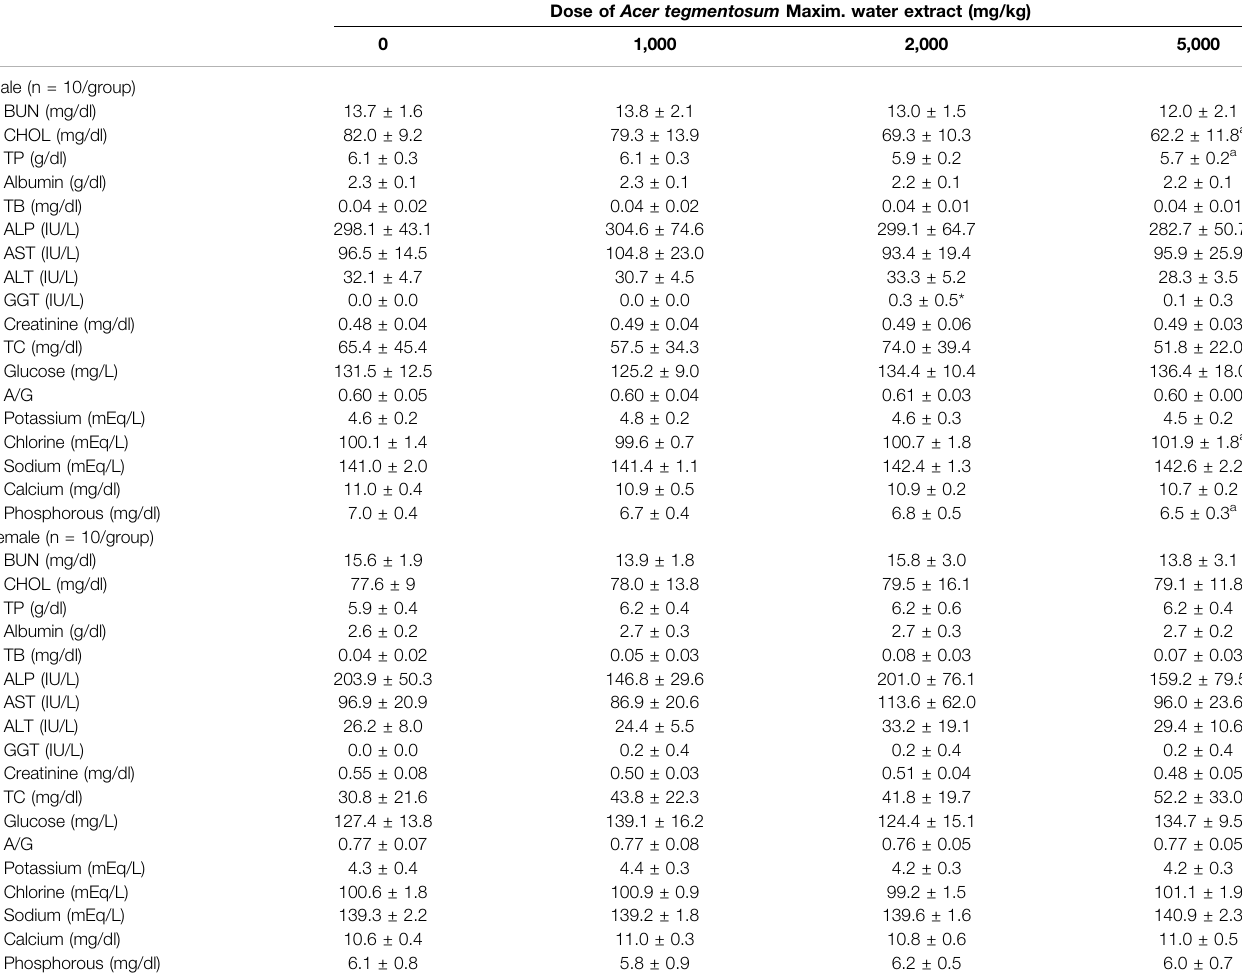
TABLE 3 | Serum biochemical parameters of SD rats orally treated with Acer tegmentosum Maxim. water extract for 90